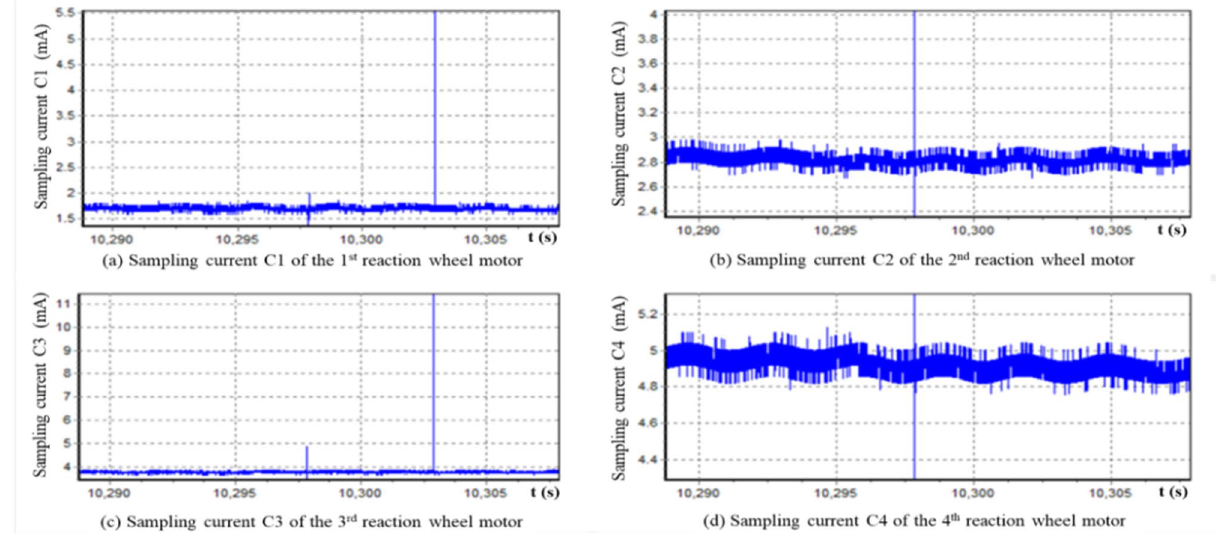
Figure 1. Plot of sampling current data from four reaction wheel motors of an on-orbit